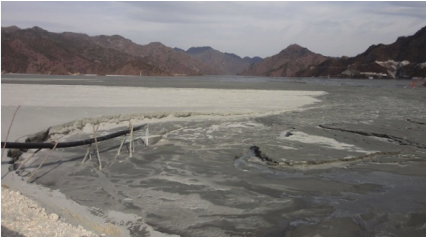
Figure 2: Current situation of the Lixi tailings dam (December 10,